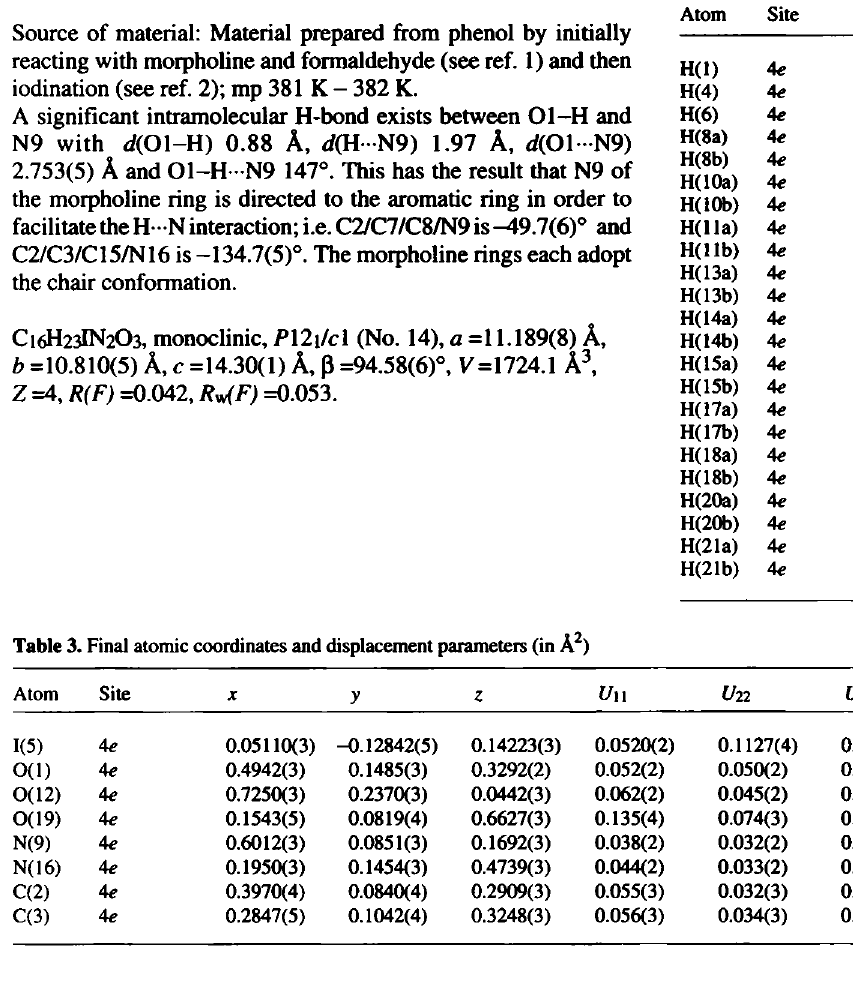
Table 2. Final atomic coordinates and displacement parameters (in Â^)